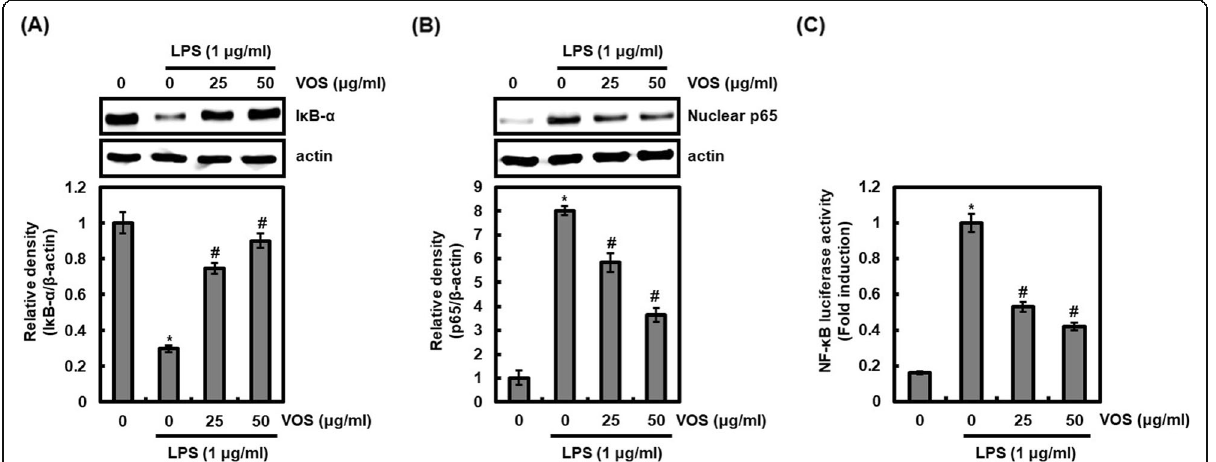
Fig. 6 Effect of VOS on NF- κ B signaling activation. a RAW264.7 cells were pretreated with VOS for 6 h and then co-treated with LPS (1 μ g/ml) for 20 min. b RAW264.7 cells were pretreated with VOS for 6 h and then co-treated with LPS (1 μ g/ml) for 30 min. After the treatment, the nucleus fraction was prepared. For Western blot analysis, the cell lysates were subjected to SDS-PAGE and the Western blot was performed using antibodies against I κ B- α and p65. Actin was used as internal control for Western blot analysis. *P < 0.05 compared to the cells without the treatment, and # P < 0.05 compared to the cells treated with LPS alone. c RAW264.7 cells were co-transfected with NF- κ B luciferase constructs and pRL-null. The cells were pretreated with VOS for 6 h and then co-treated with LPS (1 μ g/ml) for 18 h. Luciferase activity for NF- κ B was measured as a ratio of firefly luciferase signal/renilla luciferase signal using a dual luciferase assay kit. The density of Western blot bands was calculated using the software UN-SCAN-IT gel version 5.1 (Silk Scientific Inc. Orem, UT, USA). *P < 0.05 compared to the cells without the treatment, and # P < 0.05 compared to the cells treated with LPS